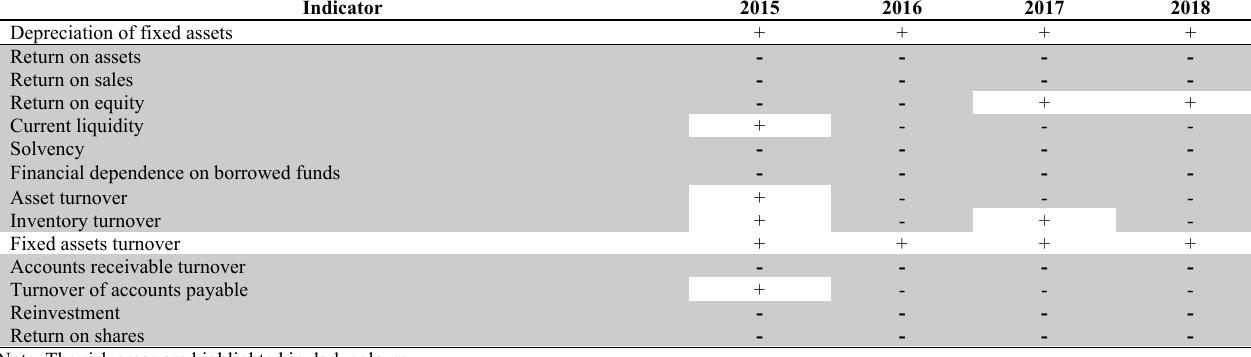
Fig. 9. Impact of restraining financial risk on the financial security level of PJSC Sumy Machine-Building Science-and- Production Association in 2015-2018, %* The scope of the restraining and stimulating financial risks of PJSC Sumy Machine-Building Science-and-Production Association